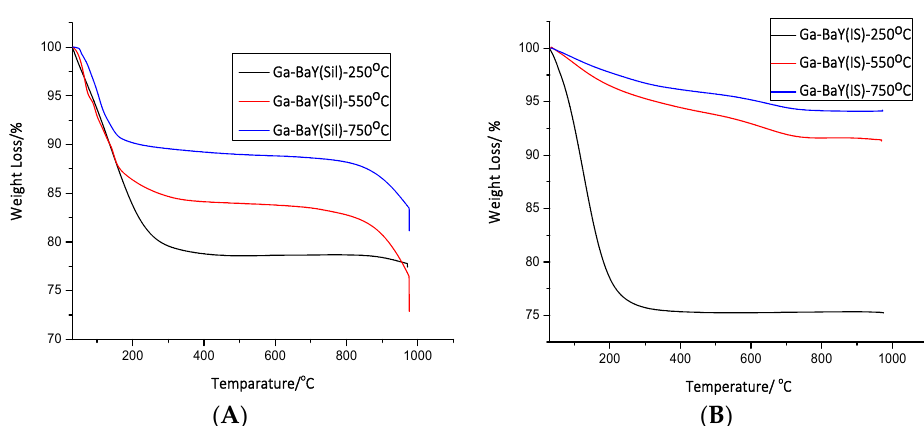
Figure 6. Thermogravimetric analysis curves of ( A ) Ga-BaY(Sil) and ( B ) Ga-BaY(IS) calcined at di ff erent temperatures.